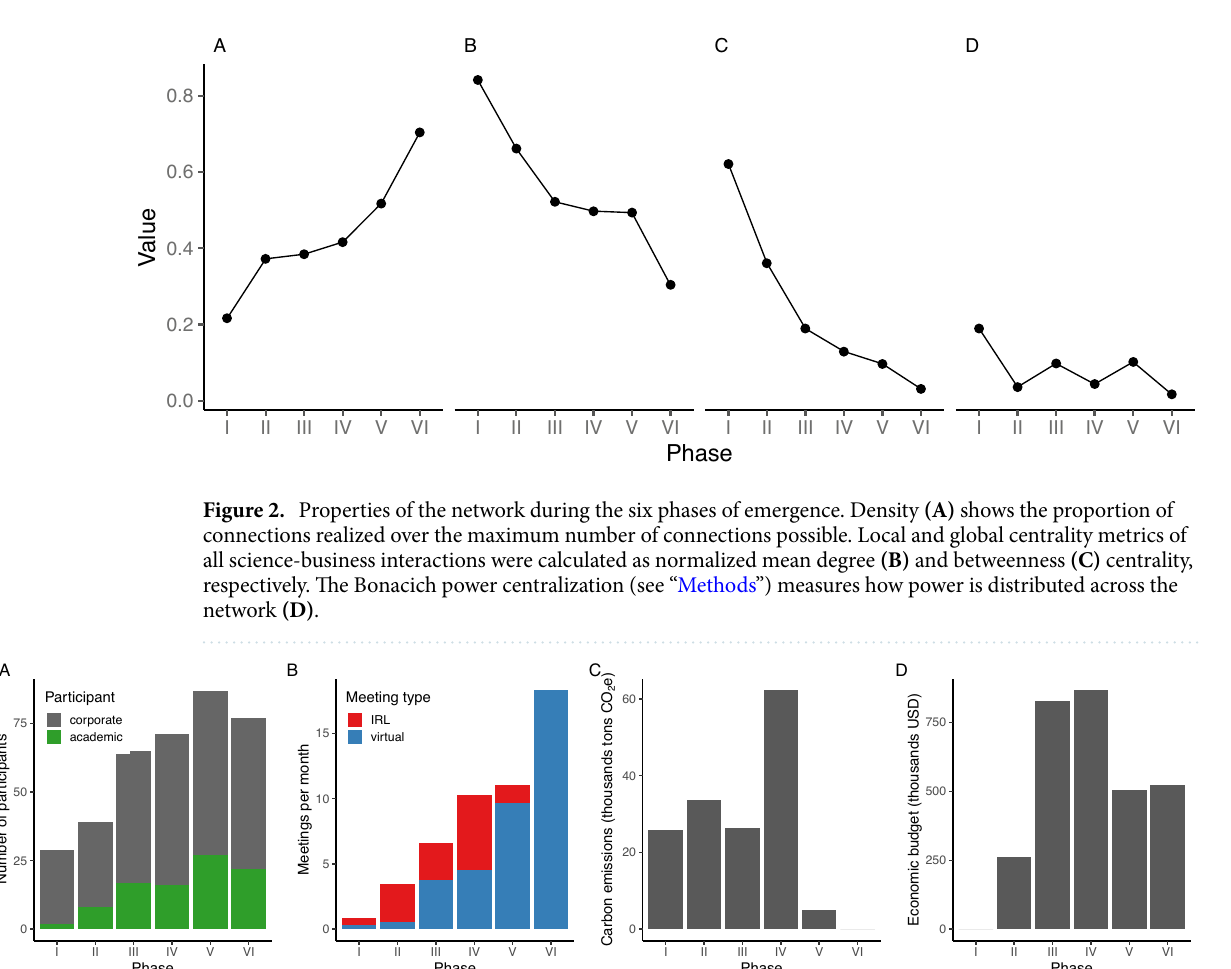
Figure 3. Science-business engagement, meeting frequency and costs. (A) The number of participants from companies and from science. (B) The frequency of virtual and in person (IRL) meetings. (C) The science-team travel-related carbon emissions (CO 2 e). (D) Dedicated science budget